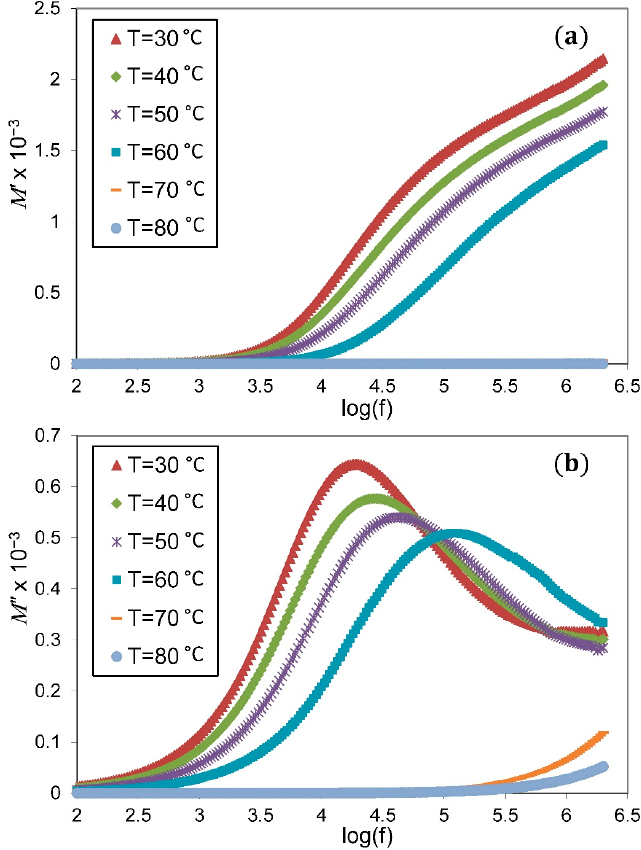
Figure 8. Plot of ( a ) real ( 𝑀 (cid:4593) ) and ( b ) imaginary ( 𝑀 (cid:4593)(cid:4593) ) parts of electric modulus versus frequency for the PVA/NH 4 NO 3 doped 2 wt.% ZnO at various temperatures. A shift in the 𝑀′′ relaxation peak towards the higher-frequency side with a temper- ature rise indicates the reduction in the relaxation time, which directly supports the ionic conductivity enhancement as a consequence of an increase in the mobility of free ions [17]. According to Khiar and Arof [46], as temperature increases, the degree of salt dissociation and re-dissociation of ion aggregates causes an increase in the number of free ions.